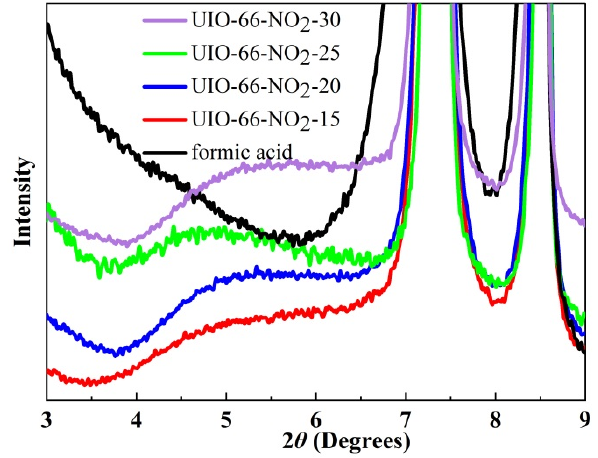
Figure 2. PXRD patterns of UiO-66-NO 2 -X in the low-angle (3–9 ◦ )